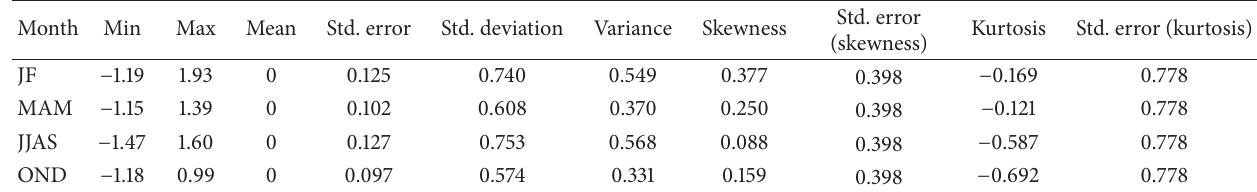
Table 8: General statistics of MSLP.